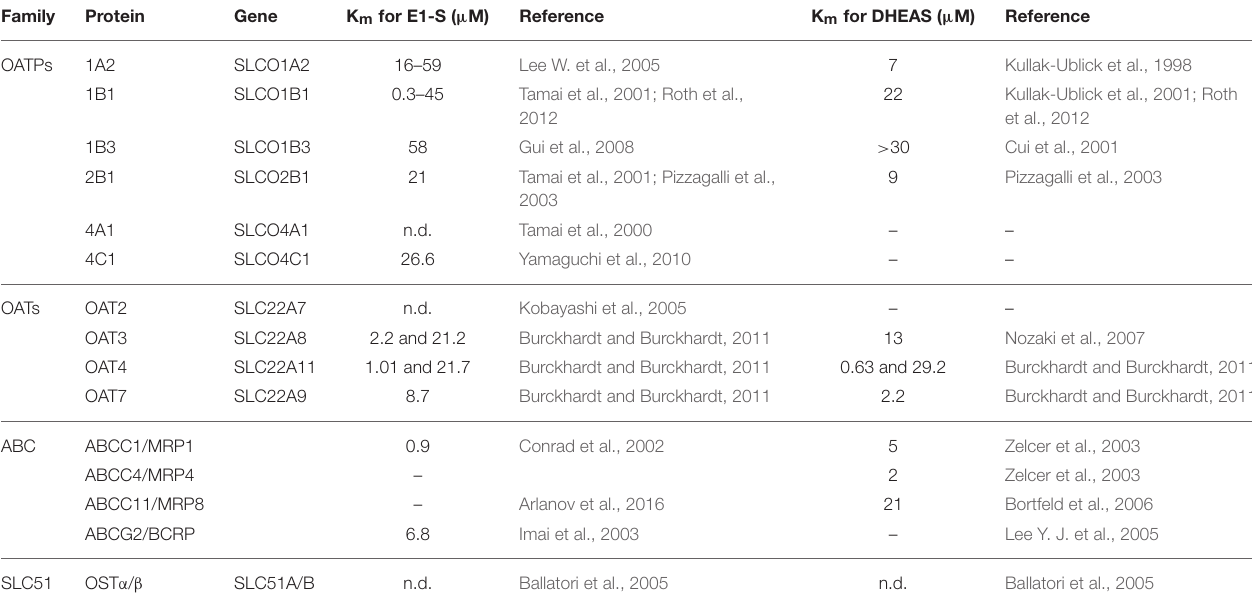
TABLE 2 | Characteristics of the most relevant E1-S and DHEA-S transporters. Family